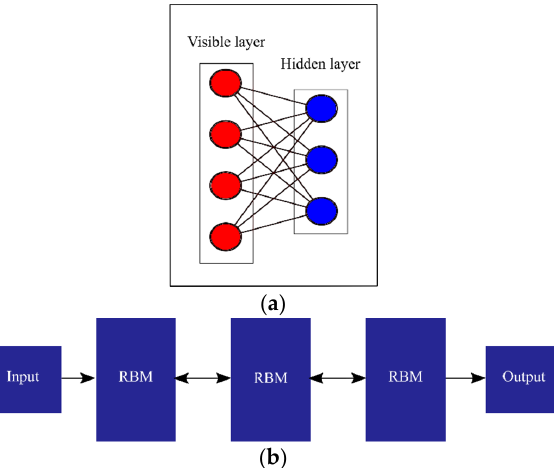
Figure 2. Deep belief network training architecture. ( a ) Description of a Restricted Boltzmann Machine (RBM) structure consisting of two layers, a hidden and visible layer, with no connection between units within the layer; ( b ) Basic Deep belief network (DBN) structure.